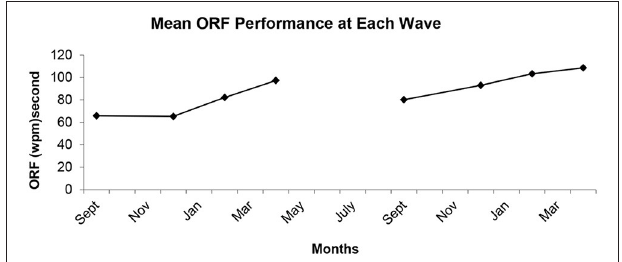
FIGURE 1 | Mean oral reading fluency levels at each wave of data collection across second and third